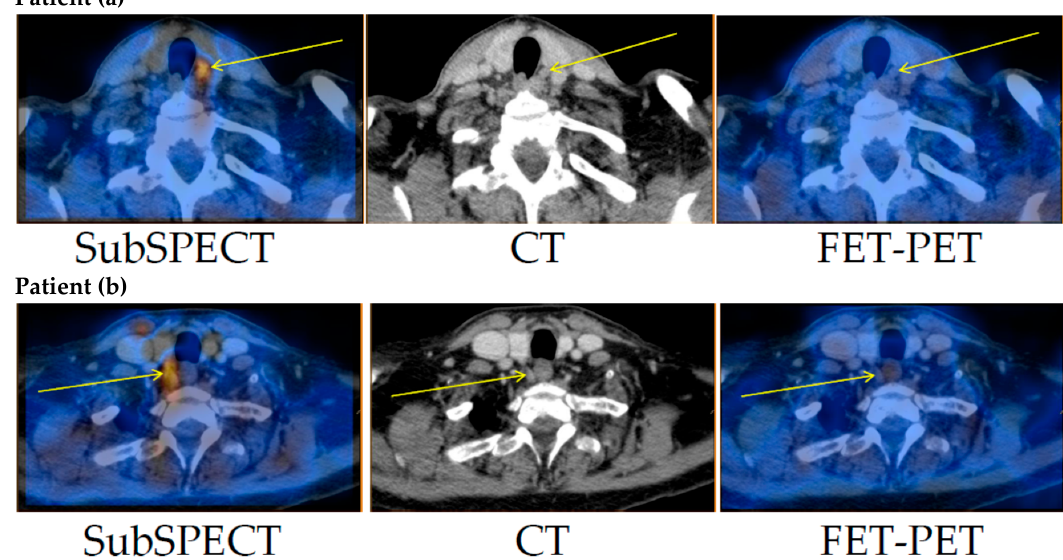
Figure 1. Tracer-uptake in the parathyroid adenomas in patients ( a ) and ( b ). Left : Subtraction (Tc-99m-sestamibi minus I-123)-SPECT/CT. Middle : CT. Right : FET-PET/CT. Thin arrows mark the surgically confirmed location of the parathyroid adenoma. FET: O -2-( 18 F)fluoroethyl- L -tyrosine; PET: positron emission tomography; SPECT/CT: single photon emission computed tomography/CT.